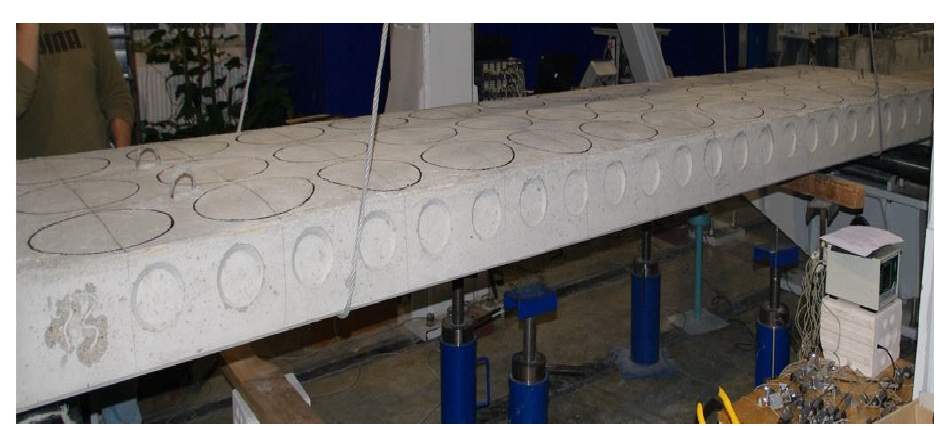
Table 1. The technical data of reinforced concrete floor slabs.